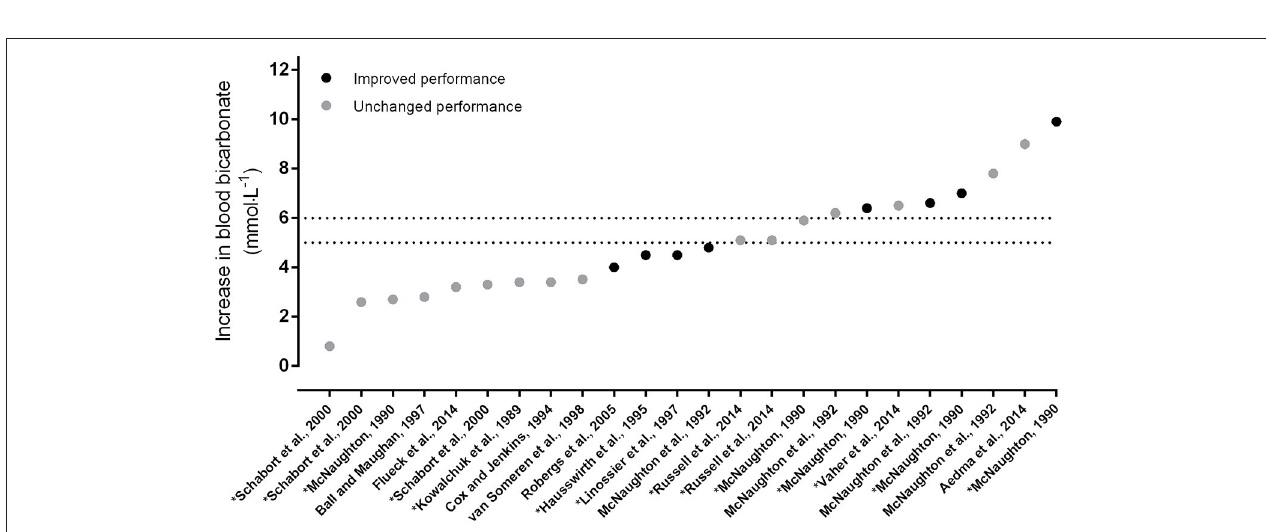
FIGURE 2 | Increases in blood bicarbonate from baseline following acute supplementation with sodium citrate, in order of magnitude of change. Data points indicate whether exercise performance was improved with supplementation (dark circles) or not (light circles). The dotted lines indicate the thresholds for the zone of a potential ergogenic effect ( + 5 mmol · L − 1 ) and the zone of an almost certain ergogenic effect ( + 6 mmol · L − 1 ); taken from Carr et al. (2) and Jones et al. (19). *Denotes data estimated from graphs using specialized software (24),